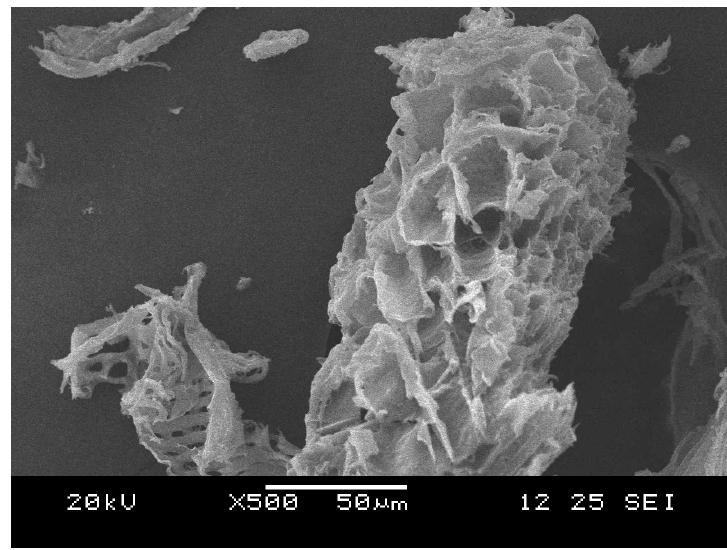
Figure 3. SEM image of SDB.